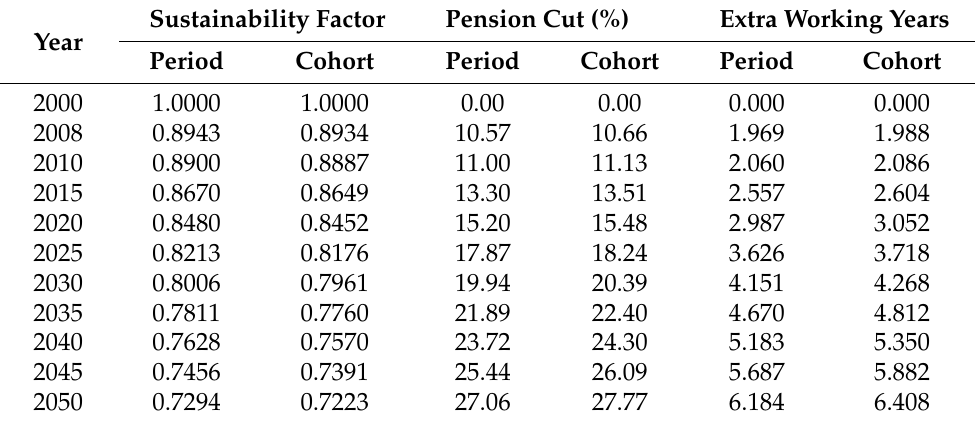
Table 3. Portugal: Sustainability factor, pension cuts, and extra working years